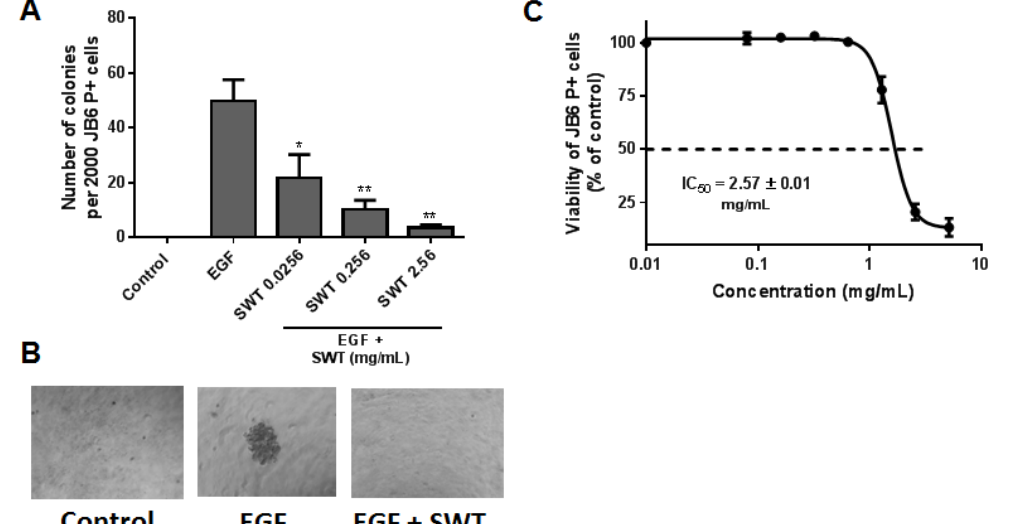
Figure 1. Effects of SWT extract on EGF-mediated neoplastic cell transformation and colony formation in JB6 P+ cells. ( A ) Soft agar assay data for JB6 P+ cells treated with EGF (10 ng/mL) alone or together with SWT at three concentrations. Colonies greater than ten cells were counted manually under a microscope. Data represents a mean ± standard deviation ( n = 6-12). *: p < 0.05; **: p < 0.01, compared to EGF only group; ( B ) representative images of colonies during the soft agar assay after a 10 day incubation period; and ( C ) the cytotoxic effects of SWT on JB6 P+ cells were examined using an SRB assay. Results are expressed as percentage of viability versus control cells with no drug treatment.